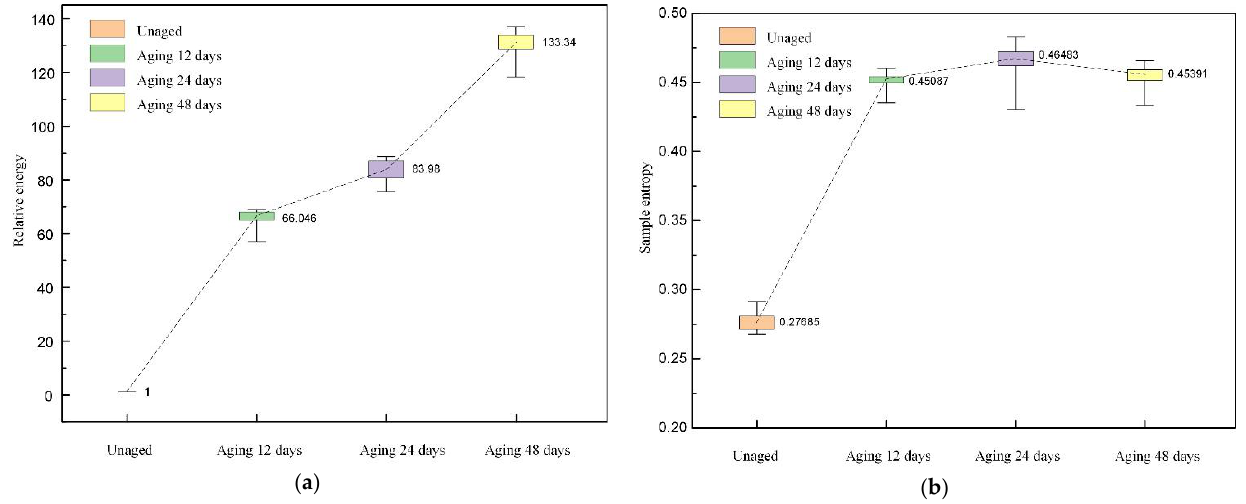
Figure 12. The distribution of relative energy and sample entropy. ( a ) Relative energy; ( b ) sample entropy.